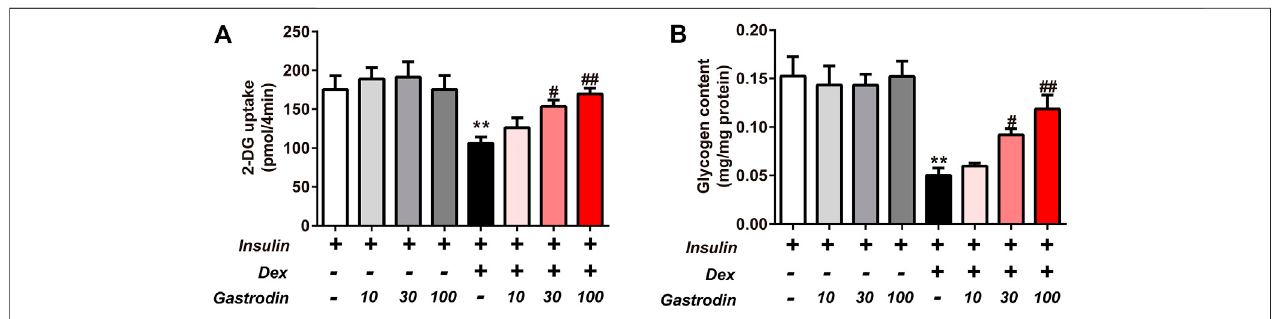
FIGURE8| EffectsofGastrodinonGlucoseuptakeassayandGlycogencontentassayinHepG2cells.The fl uorescenceintensityof2-NBDGintoHepG2cells (A) . The glycogen content in HepG2 cells (B) . The results were presented as mean ± SD ( n (cid:1) 3). ** p < 0.01, vs. insulin group, # p < 0.05, ## p < 0.01, vs. Insulin + Dex group.